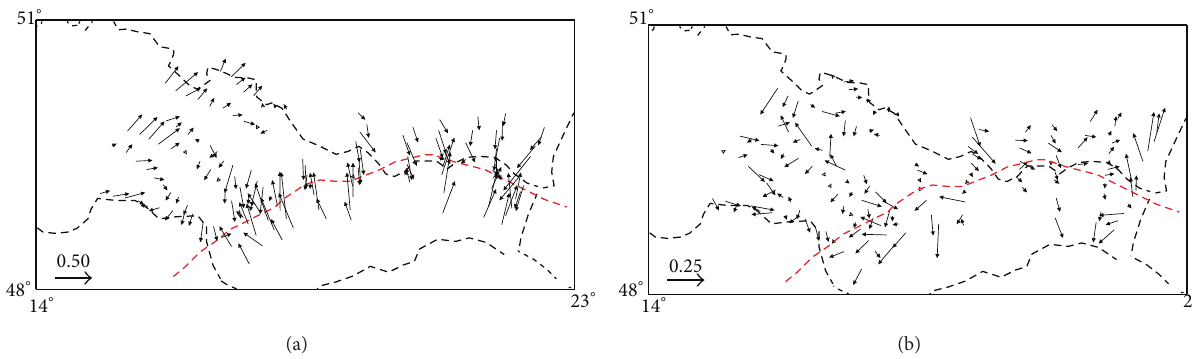
Figure 4: The GDS data represented as real part (a) and imaginary part (b) of the magnetic inductions vectors. The real part was inverted in accordance with Parkinson’s convention such that the induction arrows point towards more conductive zones. The reference magnitude of the induction arrows is given in the bottom-left corner of each map.